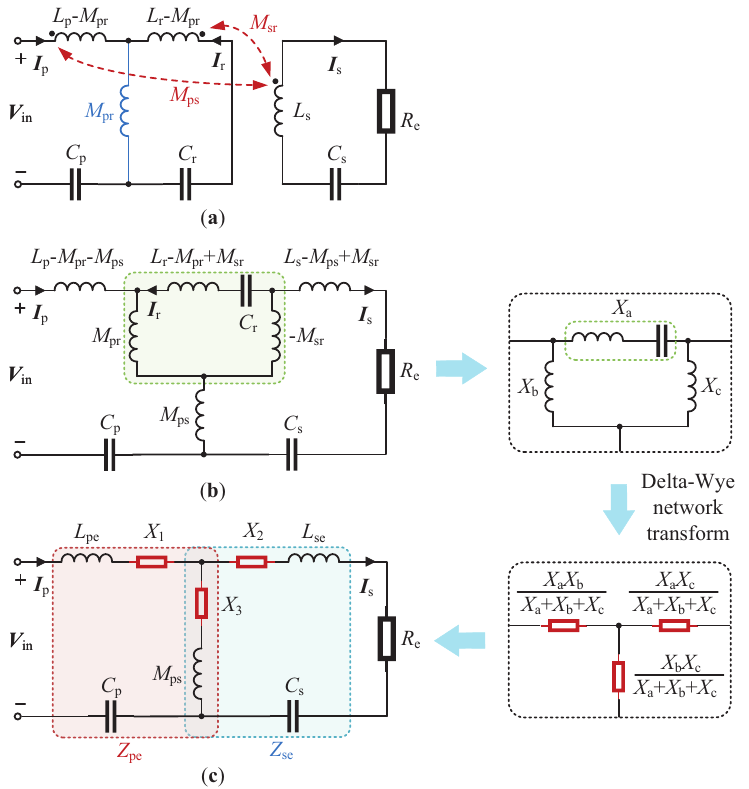
Figure 2. Equivalent circuit of the proposed S-S-S-compensated WPT system. ( a ) M pr is decoupled. ( b ) M ps and M sr are decoupled. ( c ) Simplified equivalent circuit by Delta-Wye network